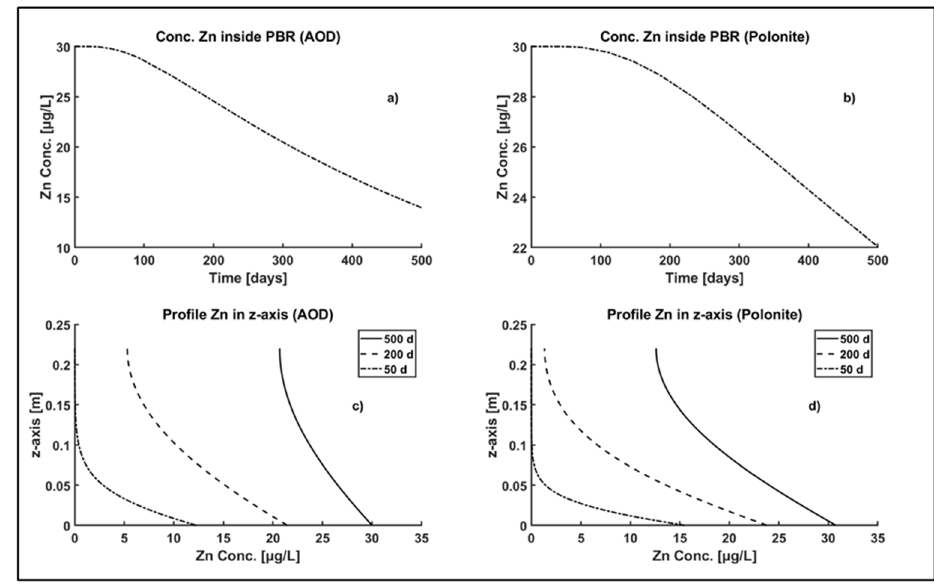
Figure 6. Comparison of the profile and gradient concentration of Zn for AOD and Polonite.